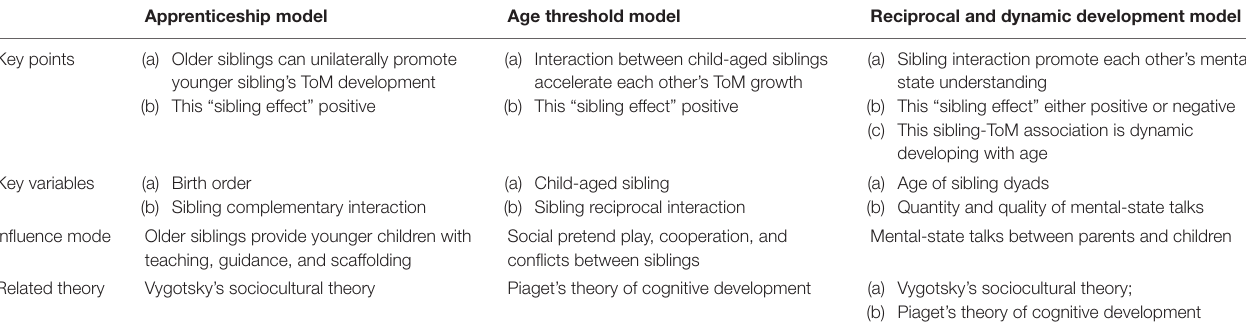
TABLE 1 | Comparison of the apprenticeship model, the age threshold model, and the reciprocal and dynamic development model. Apprenticeship